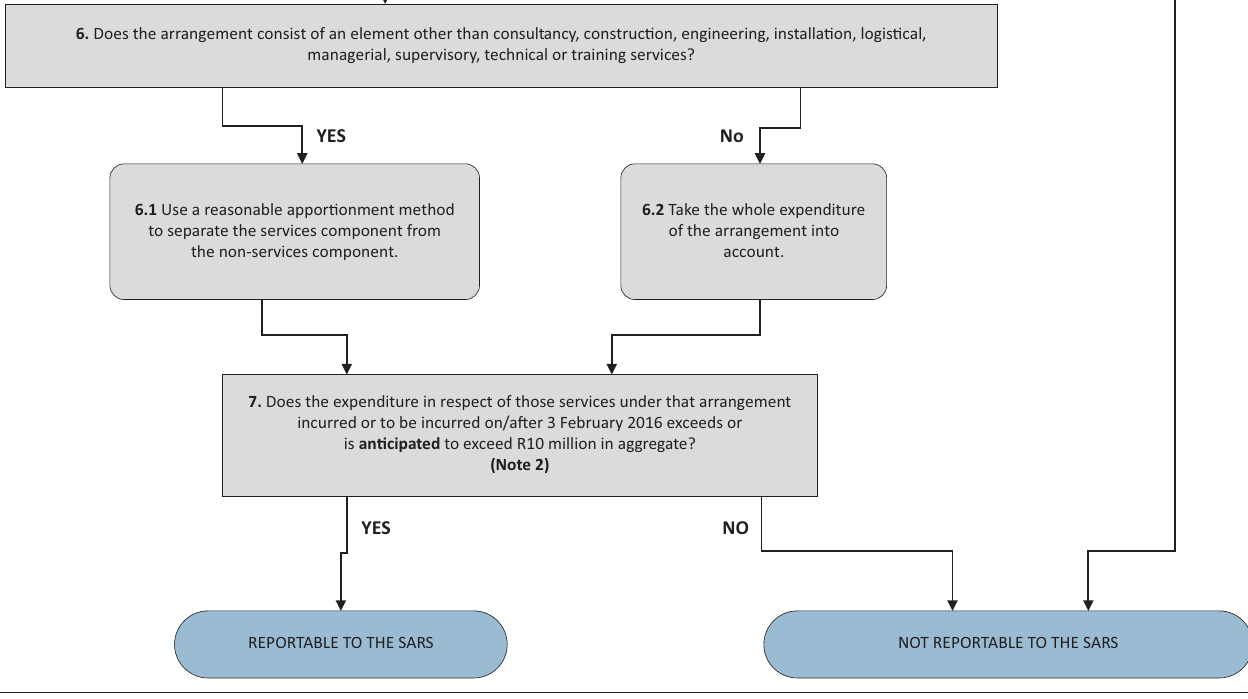
FIGURE 1: Decision